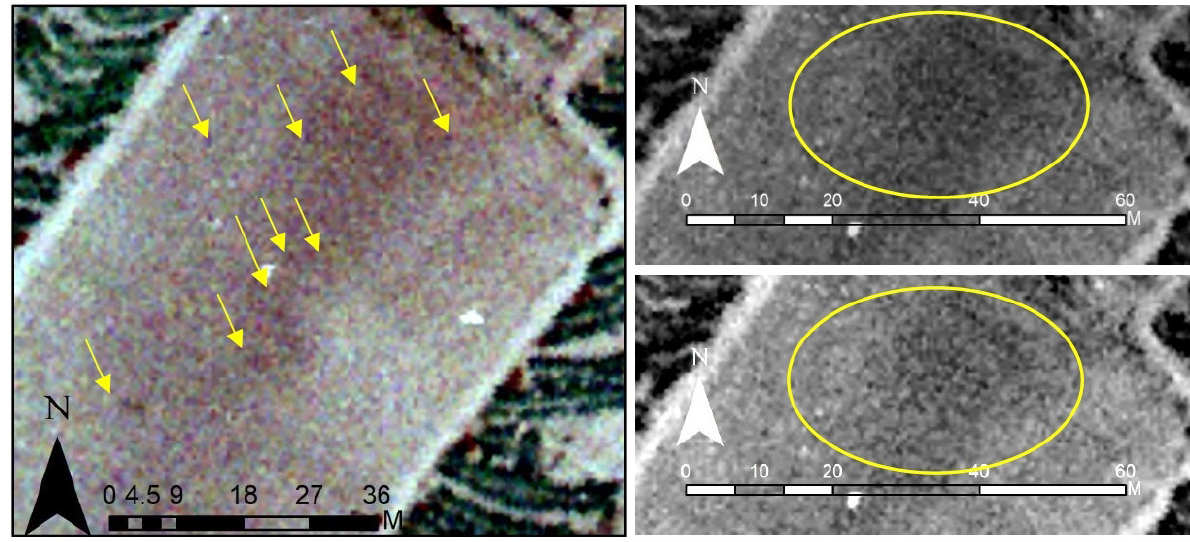
Figure 10: Proxy concentration (and loculi tomb-shaped feature) identified on the 1968 aerial photograph, at the easternmost area of the